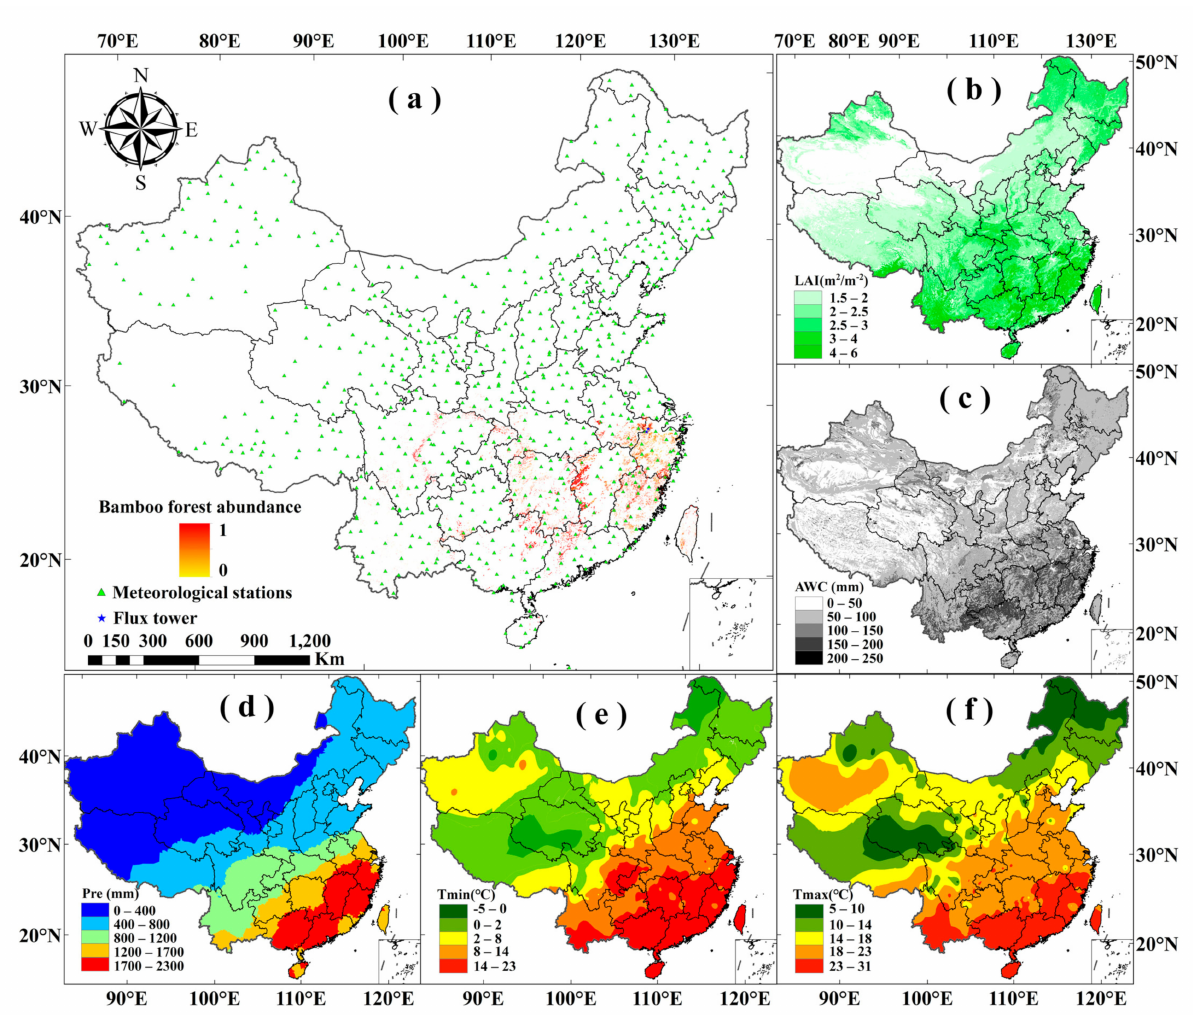
Figure 1. Study area and spatial distribution of data: ( a ) distribution of bamboo forests and me- teorological stations, ( b ) leaf area index (LAI), ( c ) available soil water-holding capacity (AWC), ( d ) precipitation (Pre), ( e ) minimum temperature (T min ), and ( f ) maximum temperature (T max